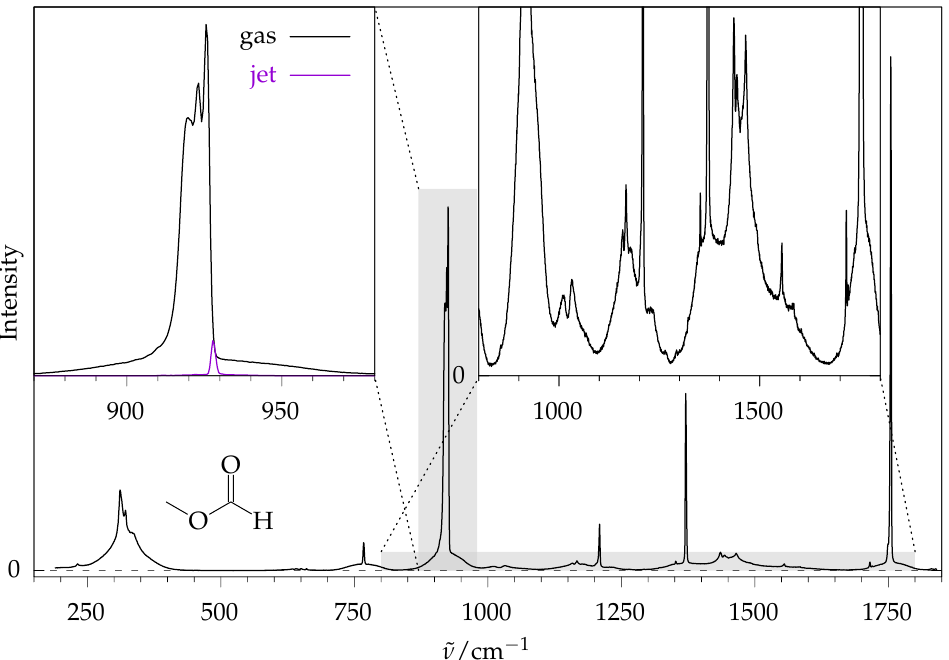
Figure 1. Gas-phase Raman spectrum of methyl methanoate. Left inset: Enlarged part of the ester linkage stretching mode ν 14 (vide infra) in comparison to a jet cooled spectrum scaled to be part of the gas phase spectrum. Right inset: Enlarged view of the baseline, which does not drop to 0 due to thermal excitation.